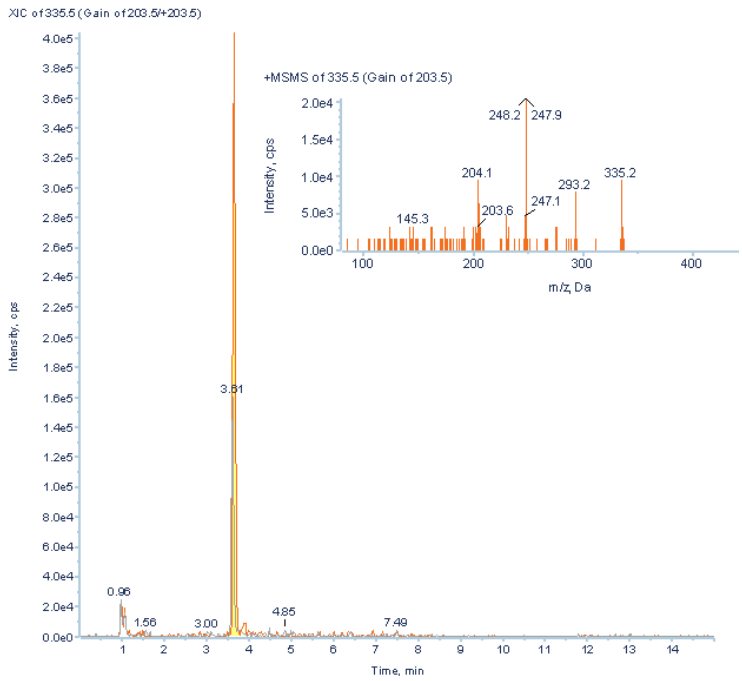
Figure 12. A nucleoside, putatively identified as N-butenoyl-guanosine ( m/z 336, RT 3.65 min), was found using positive neutral loss scan of m/z 132 on Acquity UPLC-4000 QTrap MS in pooled urine from ccRCC patients ( orange line ) two-folds higher than in post-operative controls ( grey line